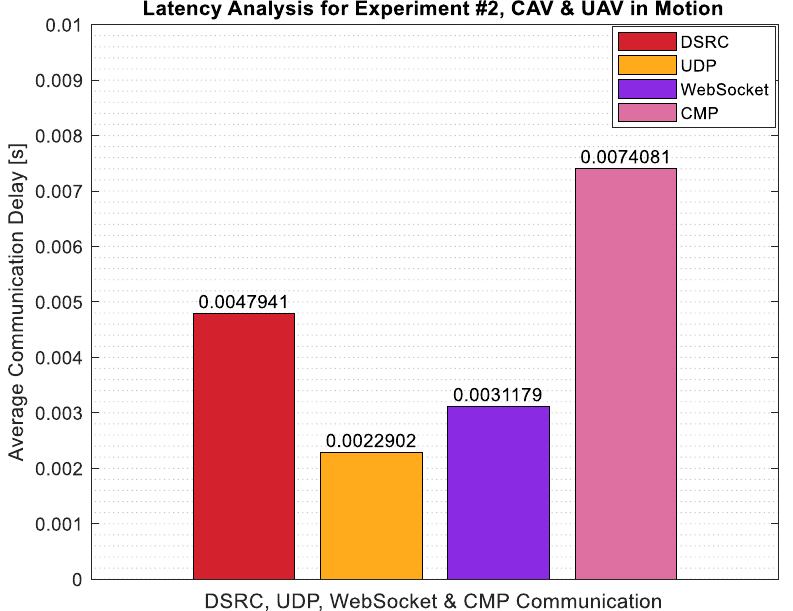
Figure 14. Latency analysis for Experiment #2, both CAV & UAV in motion. Table 1. Summary of Package Drop Percentage comparison between the four communication methods utilized in Experiment